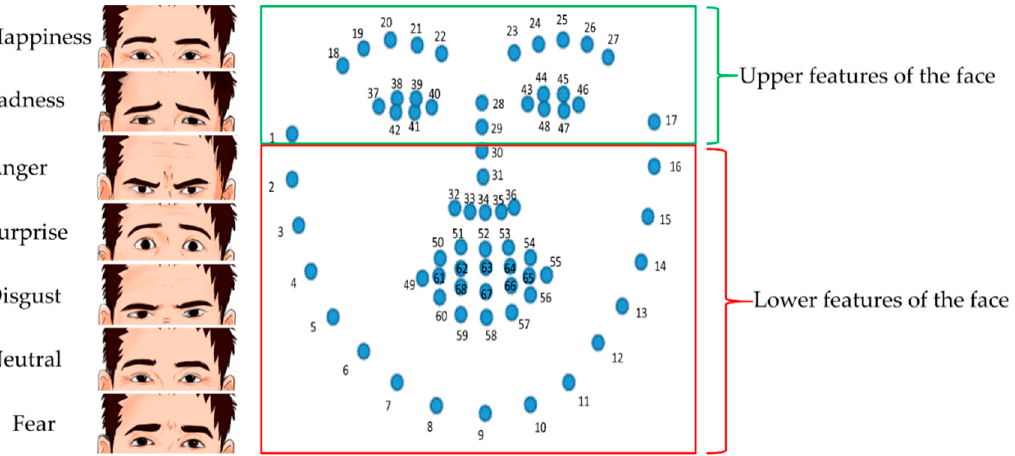
Figure 6. The standard 68 facial landmarks and seven basic emotions. (Upper and lower facial fea- tures.)